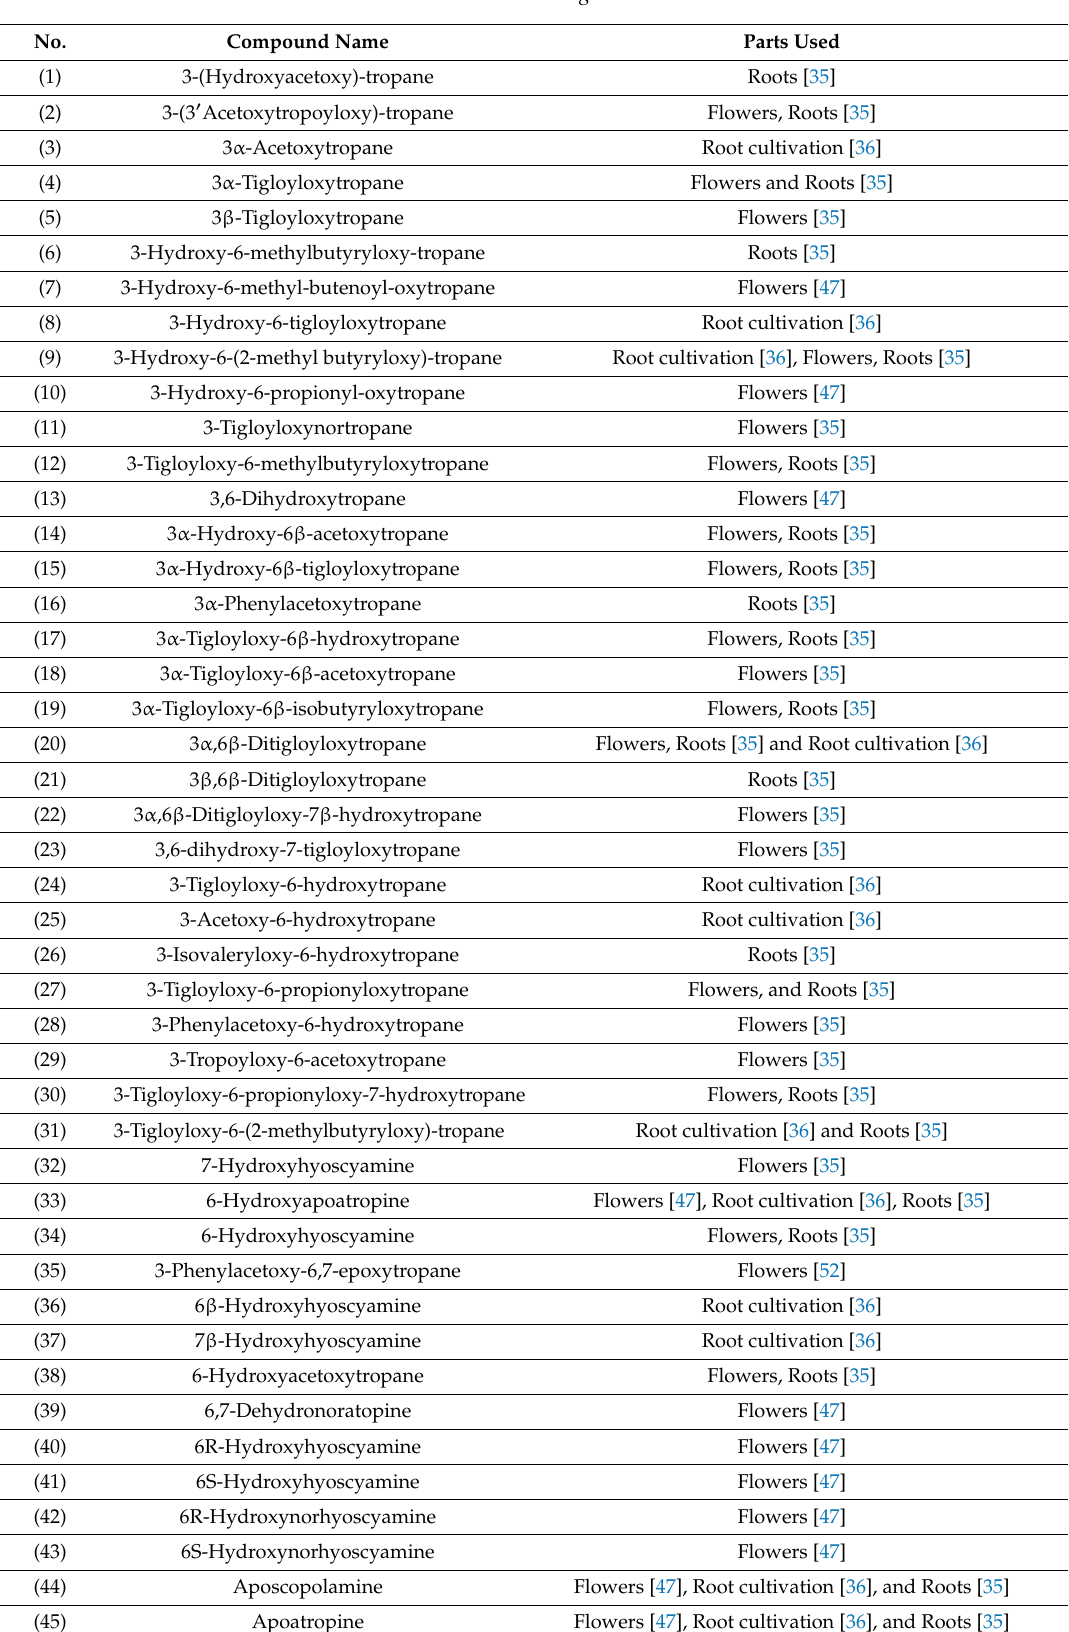
Table 2. Alkaloids from Brugmansia suaveolens